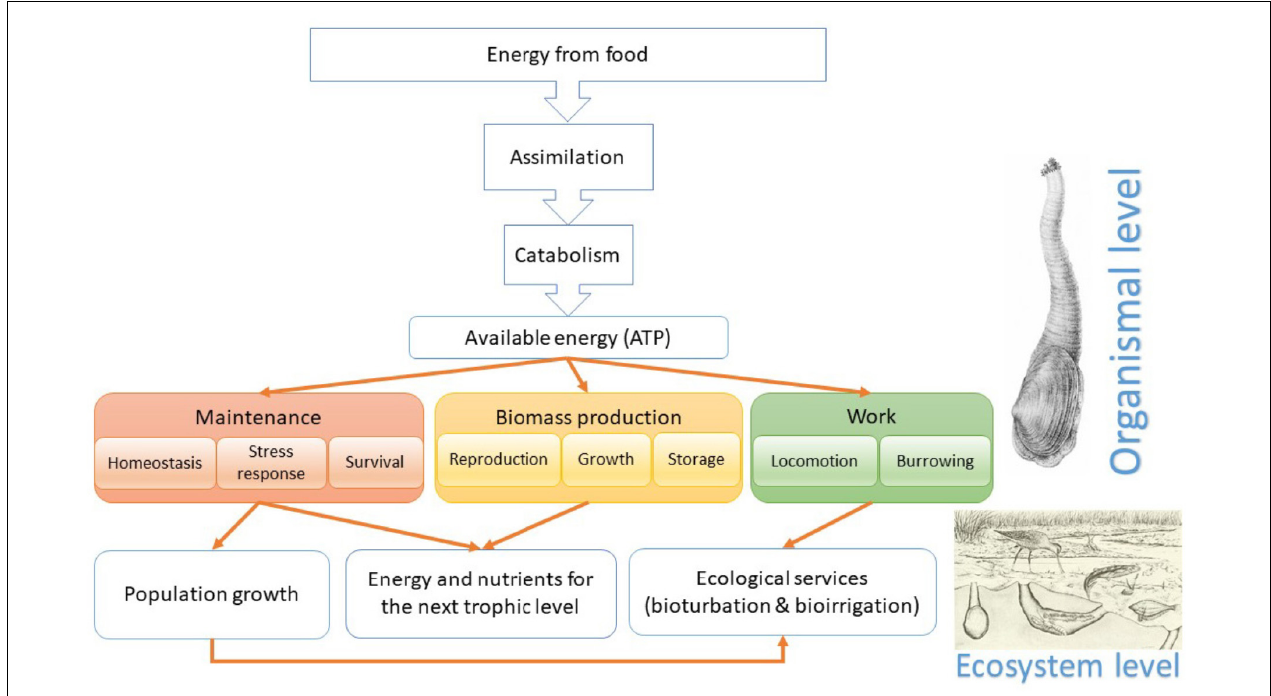
FIGURE 14 | Bioenergetics-based model integrating the physiological effects and ecological consequences of multiple stress exposures in coastal habitats. Images are obtained from the Wikimedia Commons and are in the public